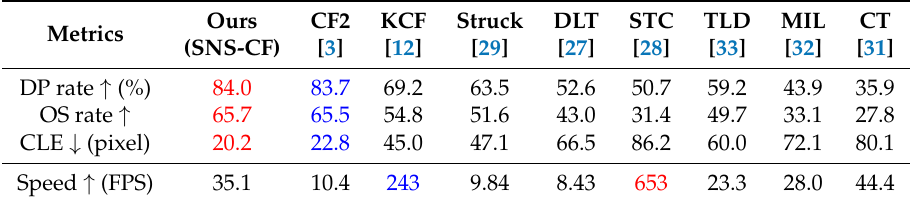
Table 1. Quantitative evaluation of SNS-CF algorithm with eight state-of-the-art trackers [3,12,27–33], considering the distance precision rate (DP) at 20 pixels, overlap success rate (OS) at 0.5, center location errors (CLE) and tracking speed, from 100 sequences of OTB-2015 [10] benchmark. Red and blue numbers indicate the best and second best results, respectively.